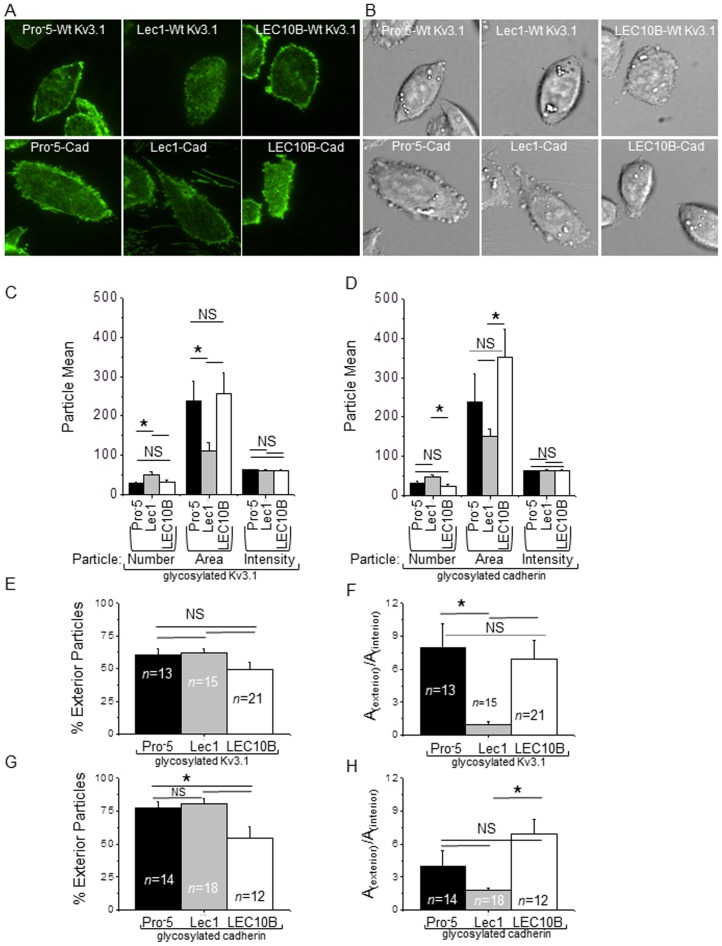
Distribution of Kv3.1 and E-cadherin at the cell surface of single cells.TIRF (A) and DIC (B) microscopy images of Pro-5 (left panels), Lec1 (middle panels) and LEC10B (right panels) cells expressing either Kv3.1 (upper panels) or E-cadherin (lower panels) are shown. Representative graphs of the mean particle numbers, areas (pixels), and intensities (AU) for Kv3.1 (C) and E-cadherin (D) are shown. The percent of particles located in the exterior region of the cell for Kv3.1 (E) and E-cadherin (G) was determined. The particle area in the exterior of the cell relative to the particle area in the interior of the cell for Kv3.1 (F) and E-cadherin (H) was calculated.